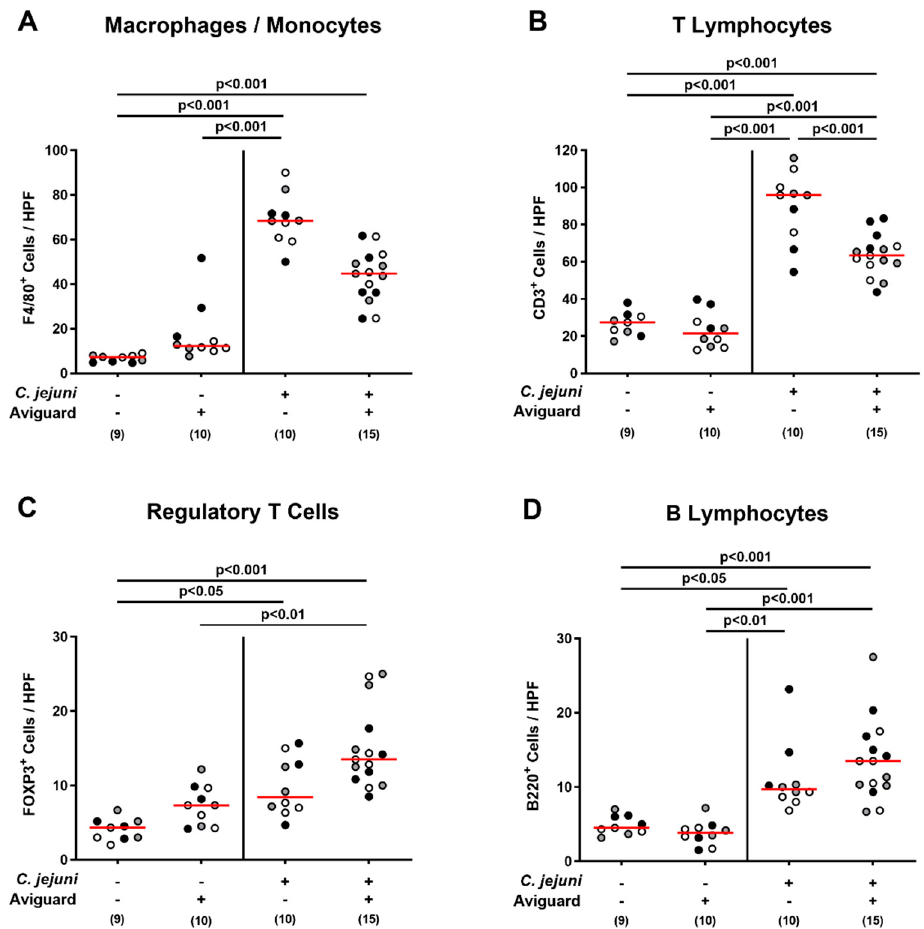
Figure 5. Aviguard ® treatment and colonic immune cell responses in C. jejuni -infected microbiota-depleted IL-10 − / − mice. Following C. jejuni strain 81-176 infection on days 0 and 1, microbiota-depleted IL-10 − / − mice were perorally treated with Aviguard ® or placebo on days 2, 3, and 4. On day 6 post-infection, the average numbers of ( A ) F4/80 + cells (macrophages and monocytes), ( B ) CD3 + cells (T lymphocytes), ( C ) FOXP3 + cells (regulatory T cells), and ( D ) B220 + cells (B lymphocytes) were determined microscopically from six high power fields (HPF, 400 × magnification) per mouse in immunohistochemically stained colonic paraffin sections. Medians (red bars), significance levels ( p values) calculated by the Kruskal–Wallis test and Dunn’s post-correction ( A , C , D ) or by the ANOVA test with Tukey post-correction ( B ) and numbers of analyzed mice (in parentheses) are indicated. Data were pooled from three independent experiments (as indicated by black, white, and gray circles).